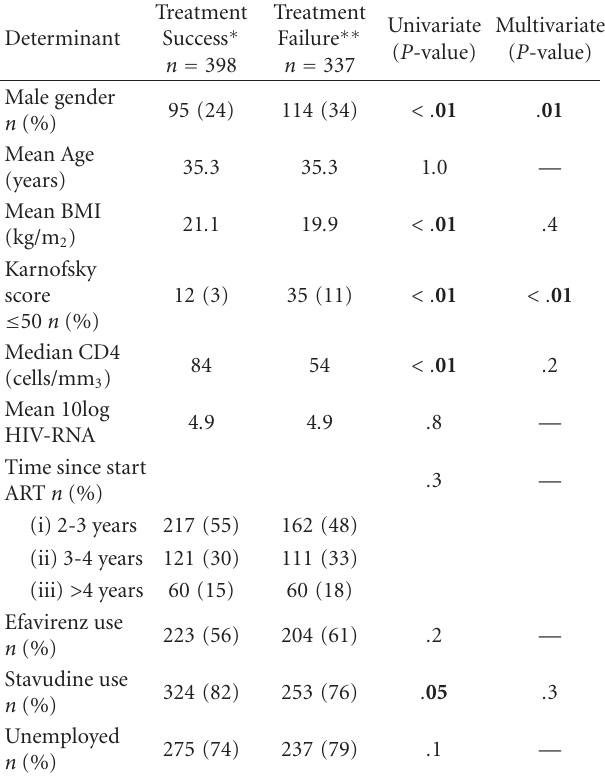
Table 1: Predictors of treatment failure.